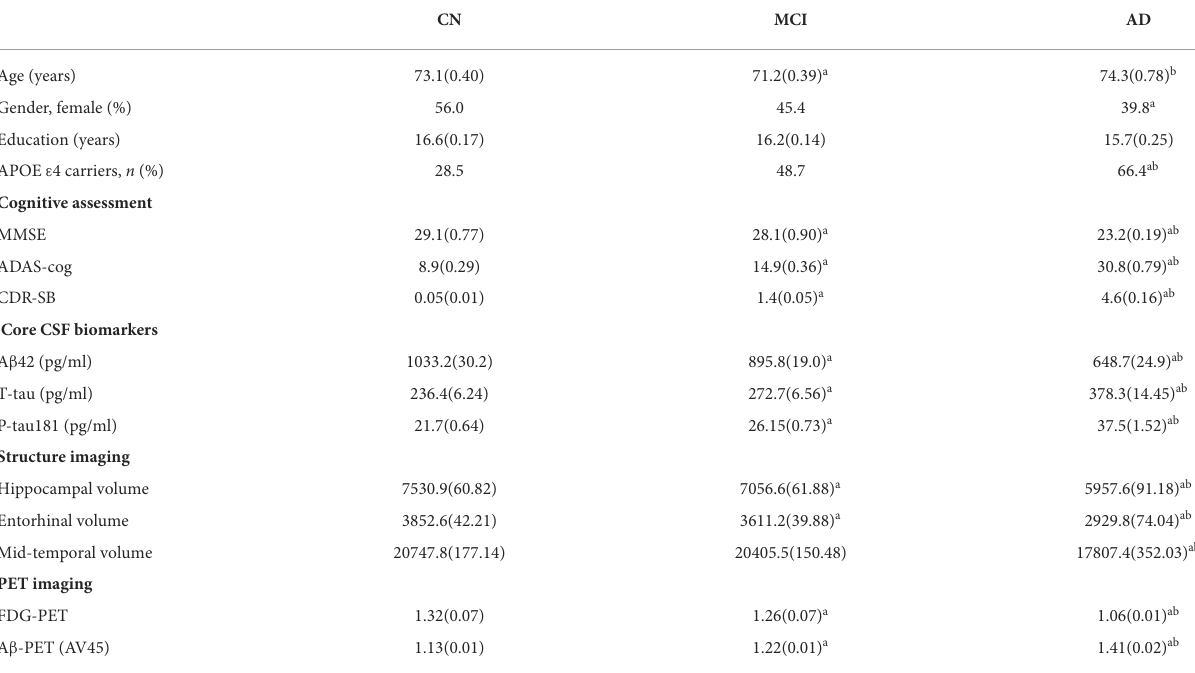
TABLE 1 Study cohort characteristics at